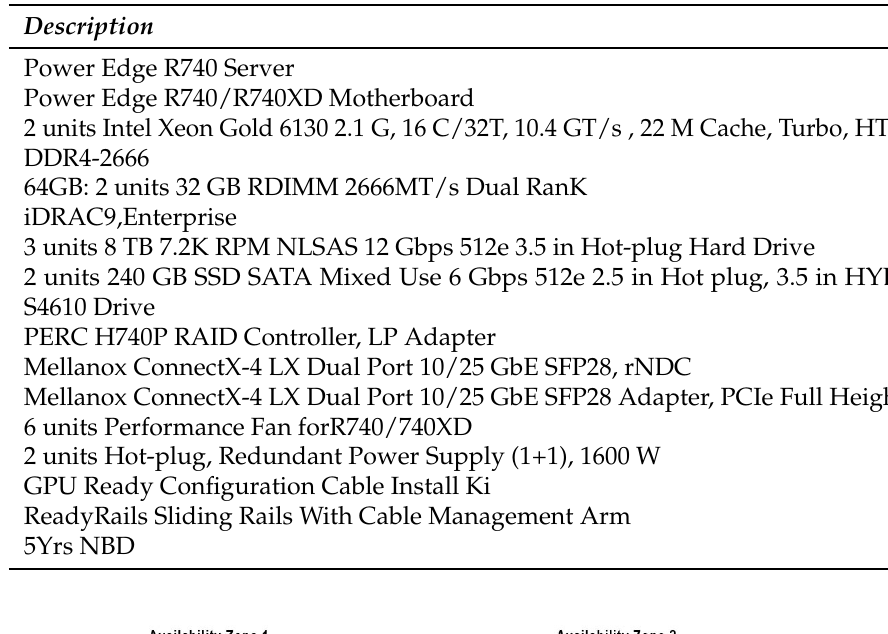
Table 5. NFV Server BoM.